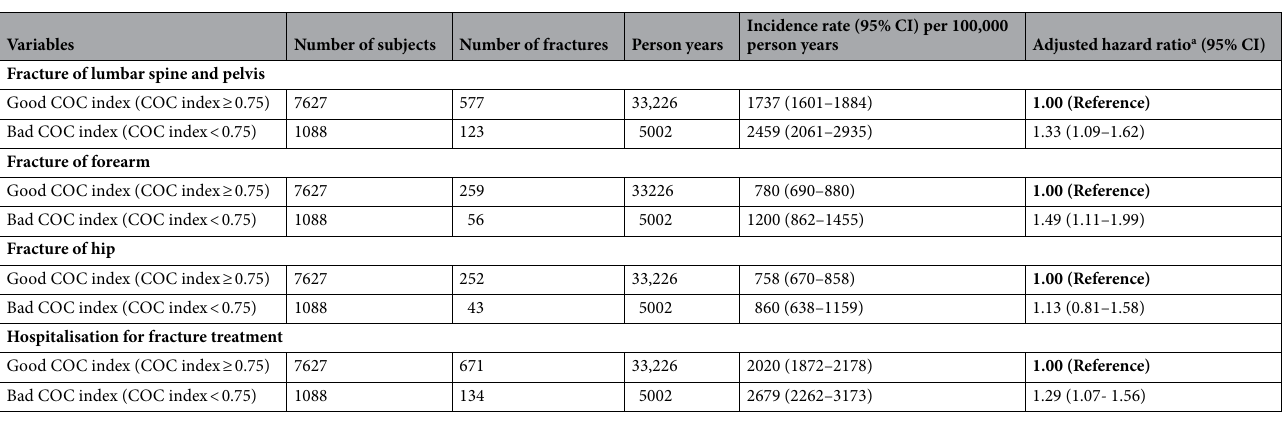
Table 4. Hazards ratio by osteoporotic fracture type and hospitalisation risk, according to continuity of care type. COC continuity of care, CI confidence interval. a Adjusted with all covariates.